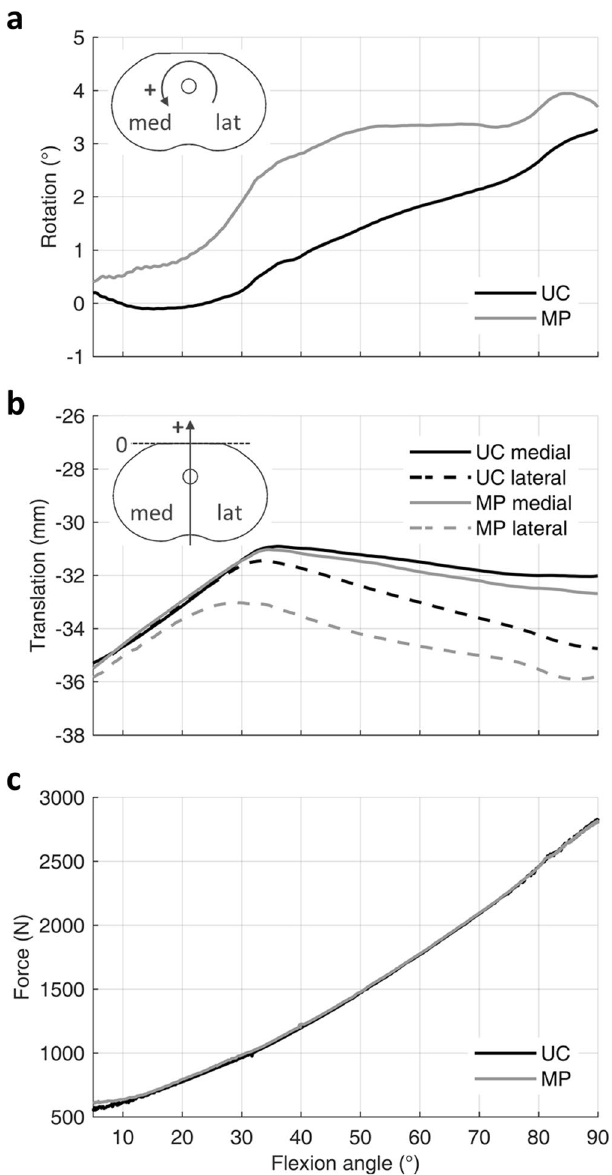
Figure 5. Kinematics and dynamics findings from the squat movement. ( a ) Tibial internal rotation; ( b ) medial and lateral femoral condyles rollback for both MP and UC inserts; ( c ) total tibiofemoral contact force during the squat